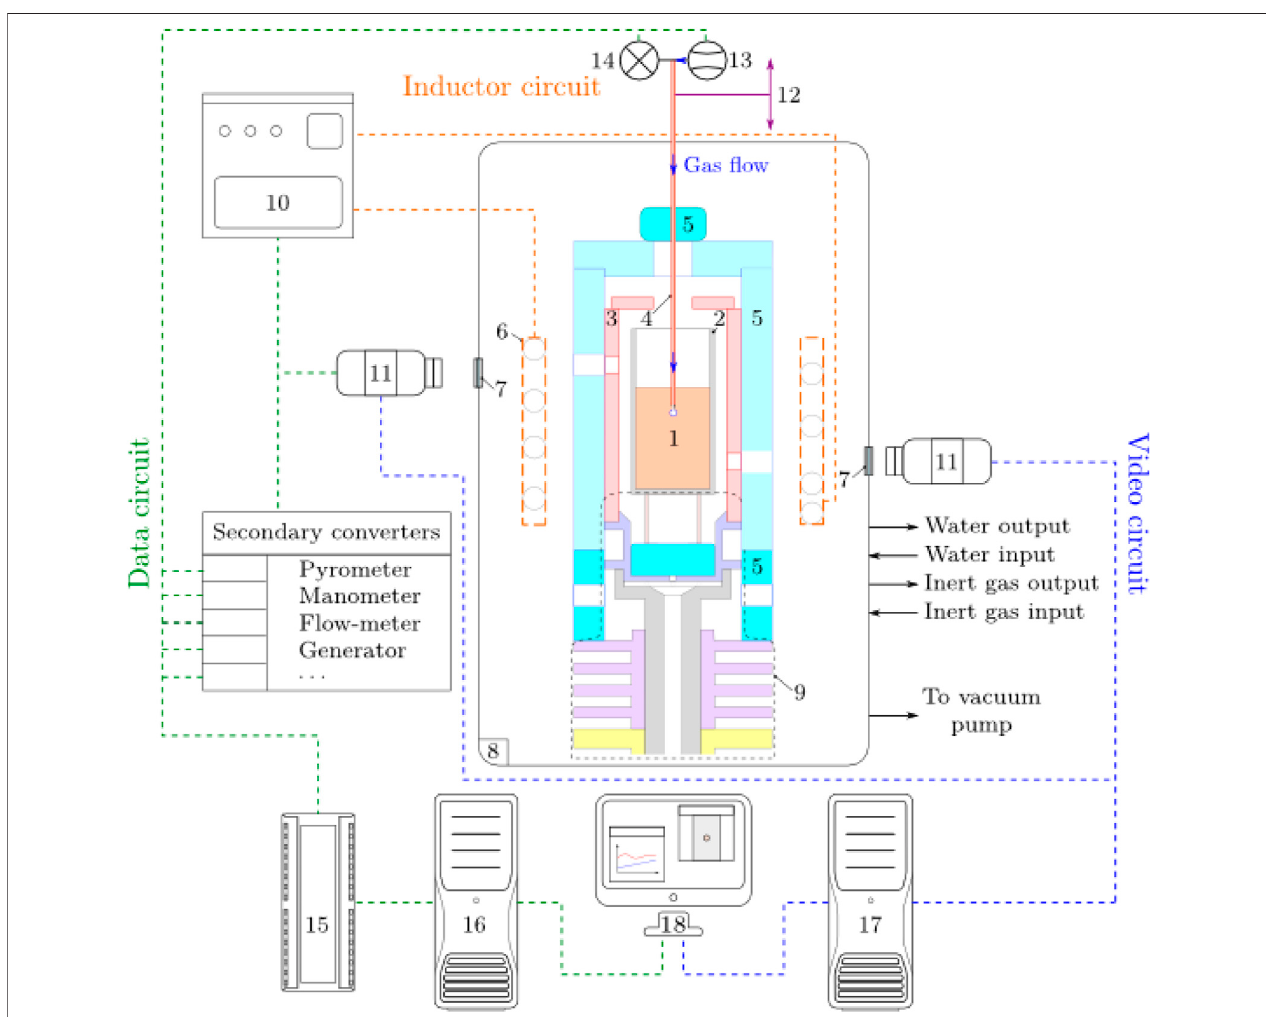
FIGURE 4 | Overall layout of VITI-MBP con fi guration (Delacroix, et al., 2022). 1: liquid pool; 2: crucible; 3: susceptor support; 4: capillary tube; 5: thermal shield; 6: inductor;7:windows;8:con fi nementvessel;9:supportingsystem;10:generator;11:pyrometers;12:µmtranslationstage;13:µ- fl owmeter;14:µ-pressuresensor;15: data bus; 16: acquisition PC; 17: imaging PC; 18: